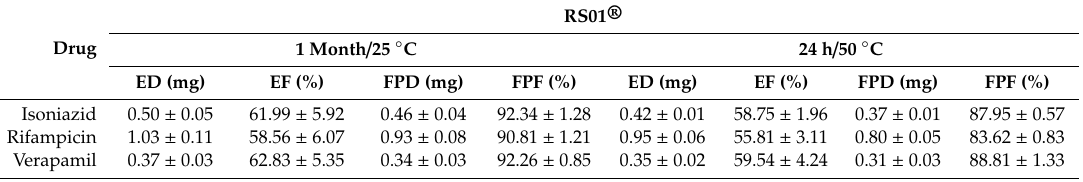
Table3. EmittedDose(ED)andFineParticleDose(FPD)ofpowderaerosolizedbyRS01 ® duringstability study, after 1 month at 25 ◦ C and after 24 h under thermal stress (50 ◦ C) ( n = 3 ± standard deviation). Table 3. Emitted Dose (ED) and Fine Particle Dose (FPD) of powder aerosolized by RS01  during stability study, after 1 month at 25 °C and after 24 h under thermal stress (50 °C) ( n = 3  standard deviation).